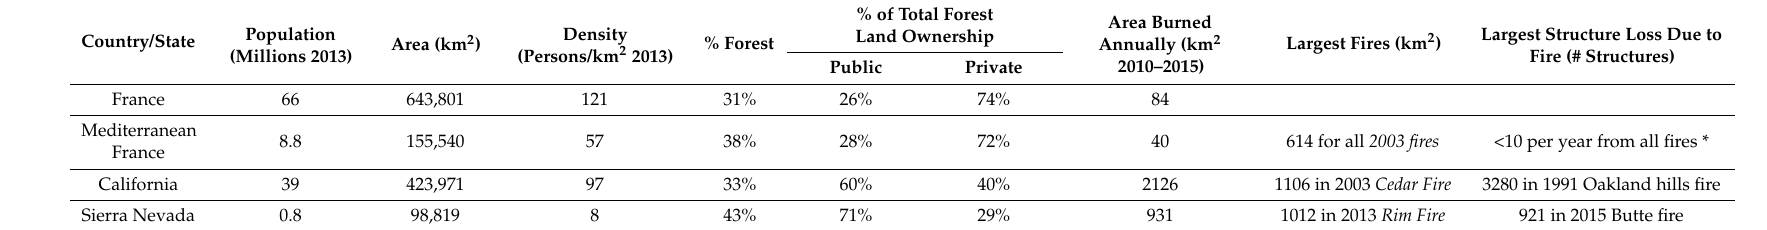
Table 1. People and Fire in California, the Sierra Nevada, France, and the 15 departments of Mediterranean